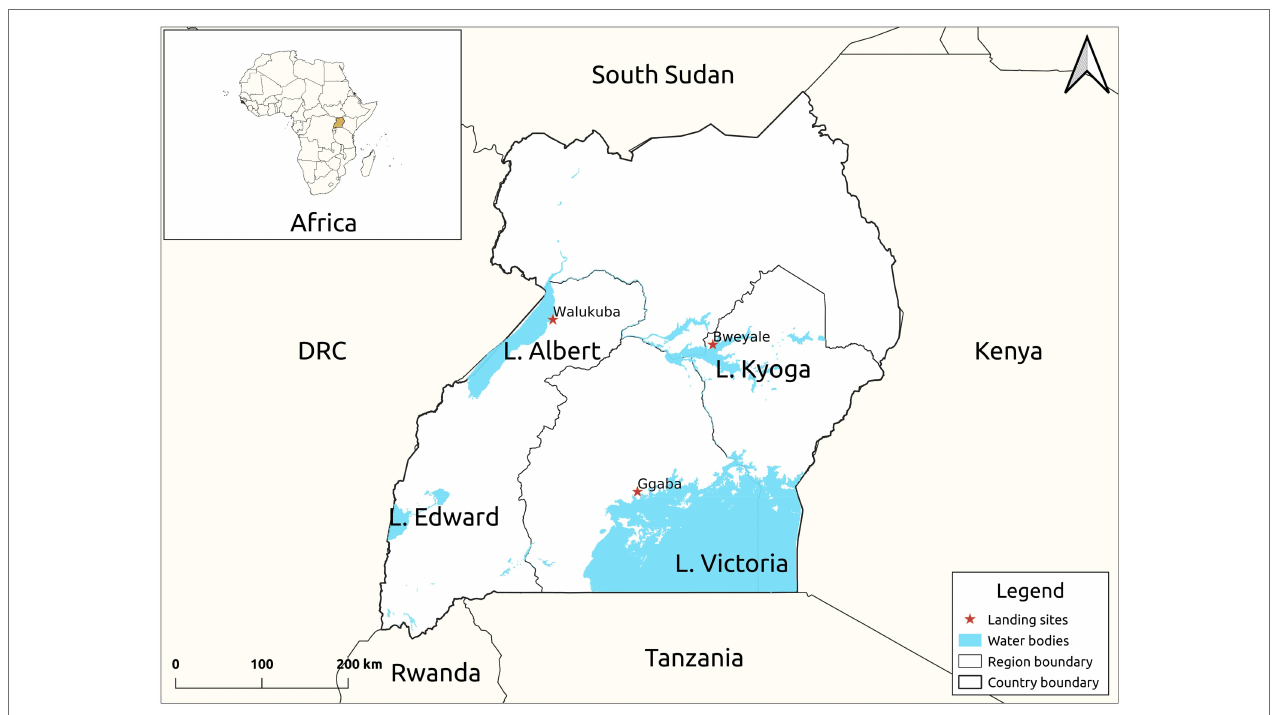
FIGURE 1 | Map of Uganda showing the study sites. The samples were collected from the landing sites of Lake Victoria, Kyoga and